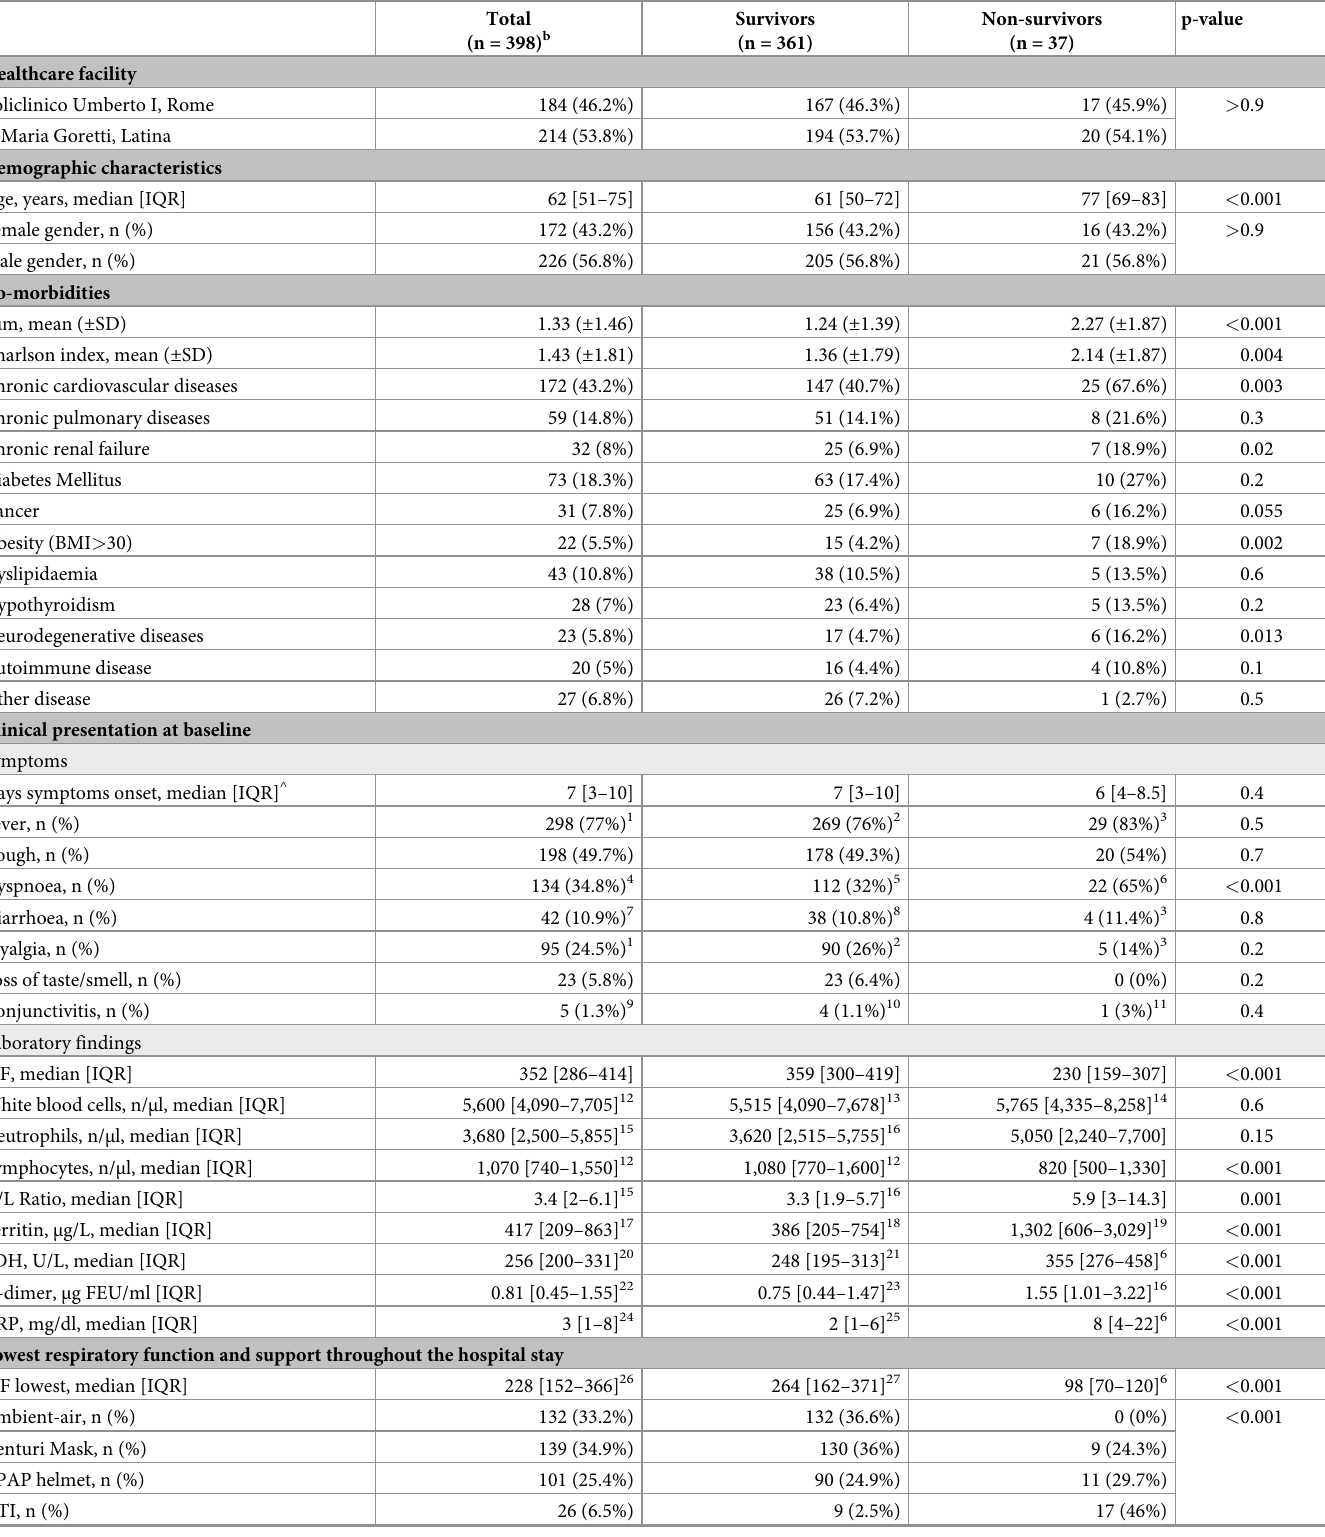
Table 4. Comparison between survivors and non-survivors for COVID-19-related death a , b